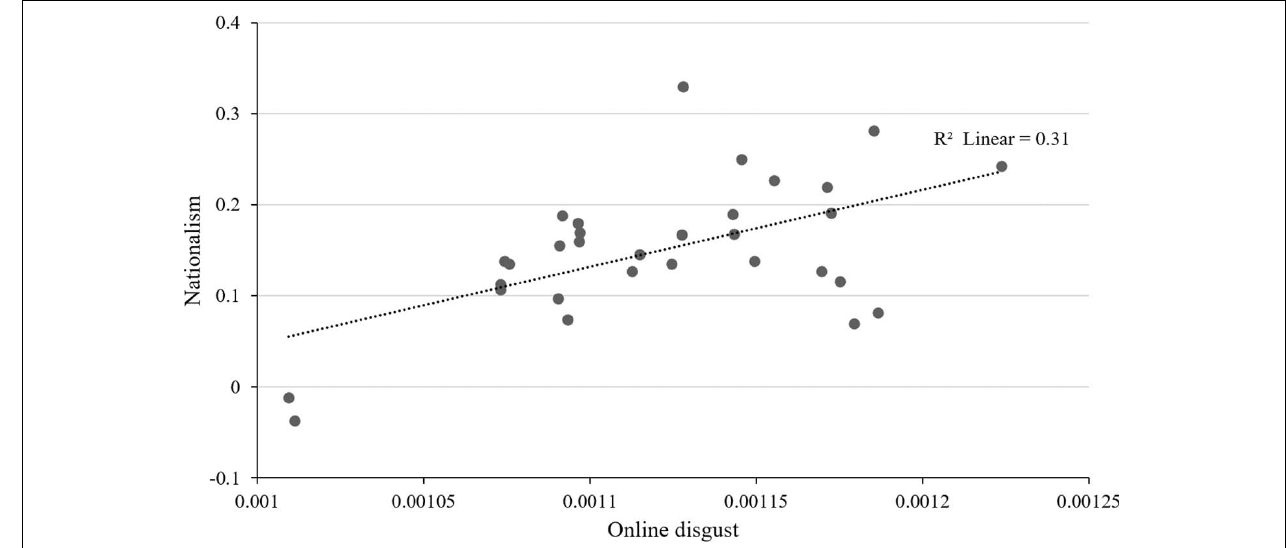
FIGURE 3 | Scatterplot of online disgust and nationalism at the provincial level.